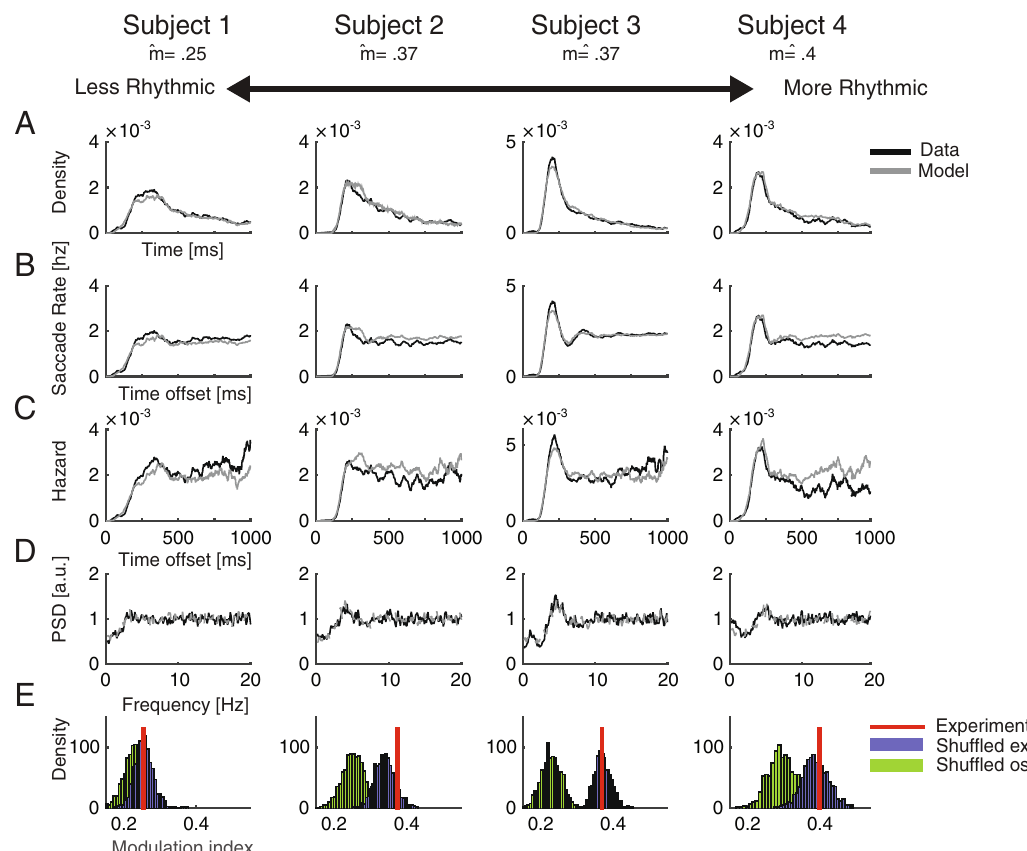
Figure 3. Statistical properties of single-subject saccade sequences during fixation (Exp 2). ( A–E ) Subjects ordered from left to right according to their level of rhythmicity as indicated by their modulation index. ( A ) Inter-saccade intervals distributions of 4 subjects (black) and their fitted first-order model (gray). ( B ) Autocorrelation functions of saccade events normalized to represent post-saccadic saccade rate. ( C ) Hazard Functions. ( D ) Power spectra of saccade sequences. ( E ) Histograms of modulation indices calculated on 1000 shuffles of intervals of either experimental data (blue) or simulated oscillatory data (green). The red bar indicates the original modulation